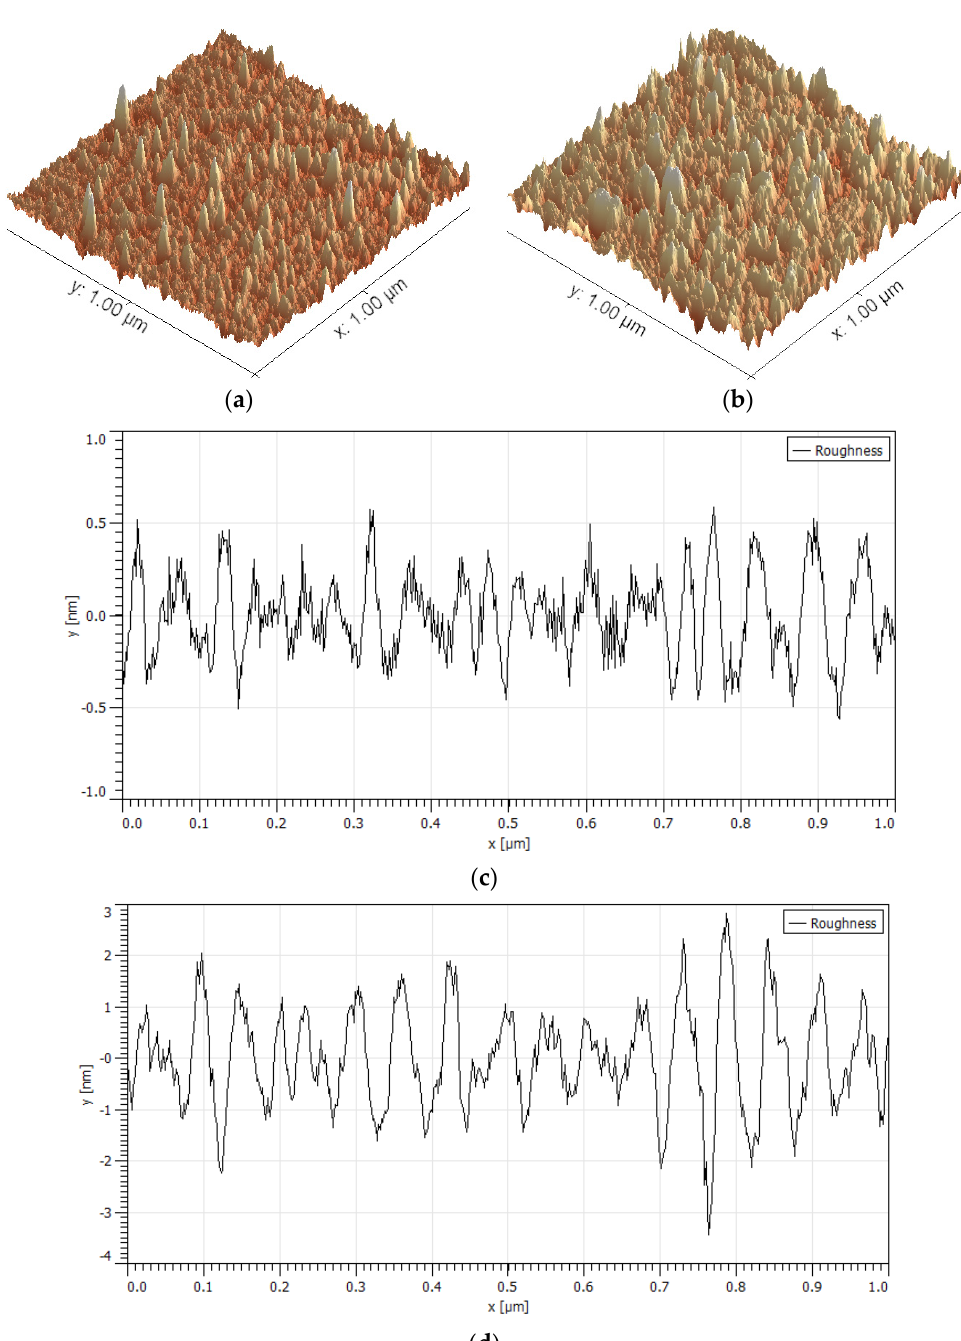
Figure 4. AFM images scan area 1 μ m × 1 μ m, ( a )—before annealing; ( b )—after annealing; ( c , d ) profiles of the films before and after annealing correspondingly.